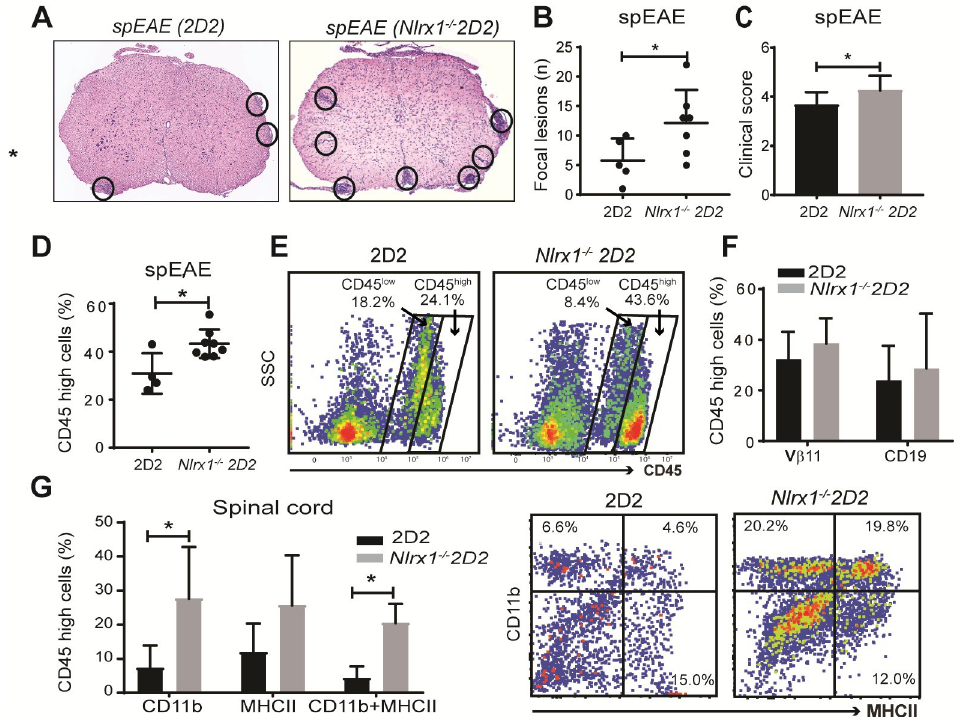
Fig 2. CNS inflammation associated with spEAE is more severe in Nlrx1 −/− 2D2 compared with 2D2 mice. (A) Representative image of HE staining of lumbar spinal cords from spEAE mice with Nlrx1 −/− 2D2 or 2D2 genotype. The circles show focal lesions. (B) The number of focal lesions counted in spinal cords from spEAE mice ( n = 5, 7 in each group). (C) EAE clinical score in Nlrx1 −/− 2D2 ( n = 18) or 2D2 ( n = 6) mice at the time of euthanization. (D) The percentage of CD45 high cells in the spinal cords of Nlrx1 −/− 2D2 spEAE ( n = 6) mice compared with 2D2 spEAE mice ( n = 4). (E) The flow cytometry plots of CD45 high gate. (F) Similar percentages of V β 11 + T cells and CD19 + B cells in the spinal cords of spEAE mice ( n = 5, 7). (G) Elevated numbers of activated CD11b + MHCII + monocyte/macrophage in CD45 high cell population, quantified in spinal cords from Nlrx1 −/− 2D2 spEAE ( n = 6) or 2D2 spEAE ( n = 4) mice by flow cytometry. Data are presented as mean ± SD. � P � 0.05 determined by the two-tailed Student t test. Underlying data can be found in S1 Data. CNS, central nervous system; EAE, experimental autoimmune encephalomyelitis; HE, hematoxylin–eosin; MHC, major histocompatibility complex; Nlrx1 , nucleotide-binding, leucine-rich repeat containing X1; spEAE, spontaneous